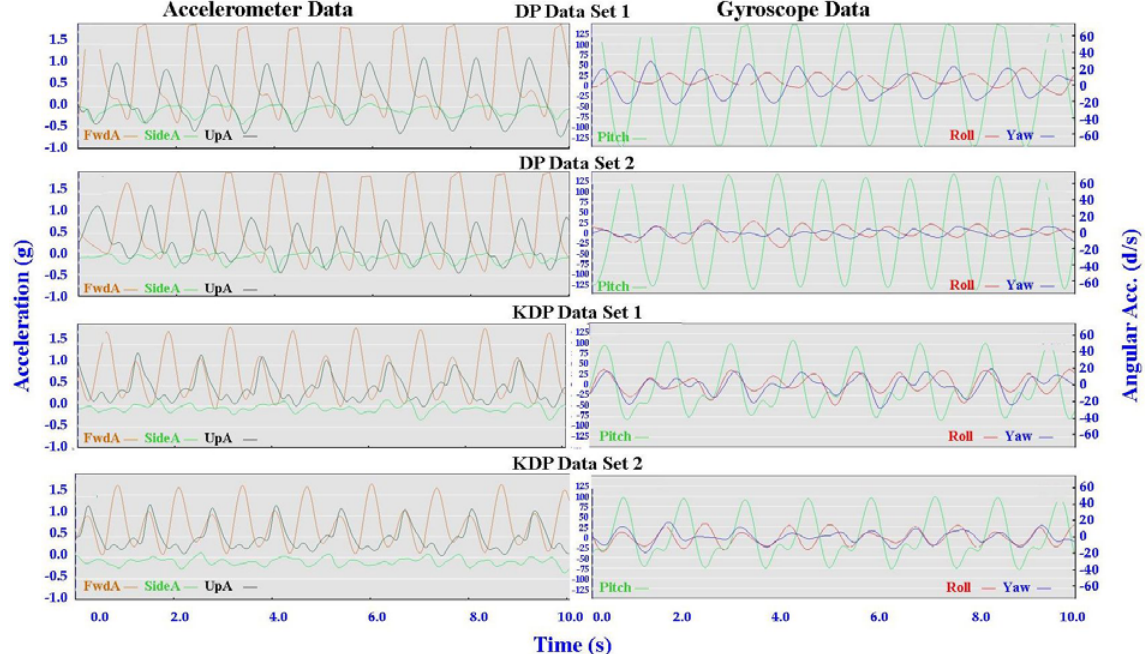
Figure 18. Longitudinal analysis of DP and KDP.